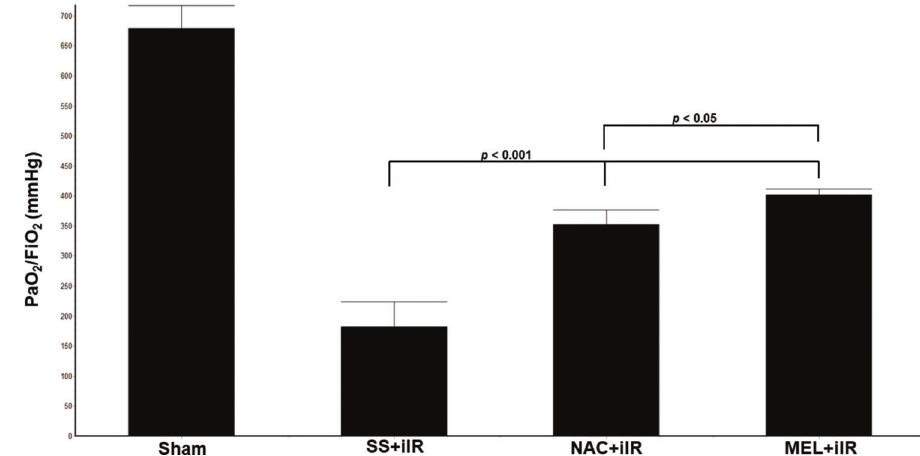
Figure 1 - Diagram showing the PaO 2 /FiO 2 levels of the animal groups. Note that PaO 2 /FiO 2 levels were significantly reduced before NAC and melatonin administration; the reduction was more evident in the MEL group. Data are shown as the mean ± standard deviation of seven rats in each group. Sham: control; SS + iIR: control intestinal ischemia-reperfusion (iIR); NAC + iIR: NAC administration and iIR; MEL + iIR: Melatonin administration and